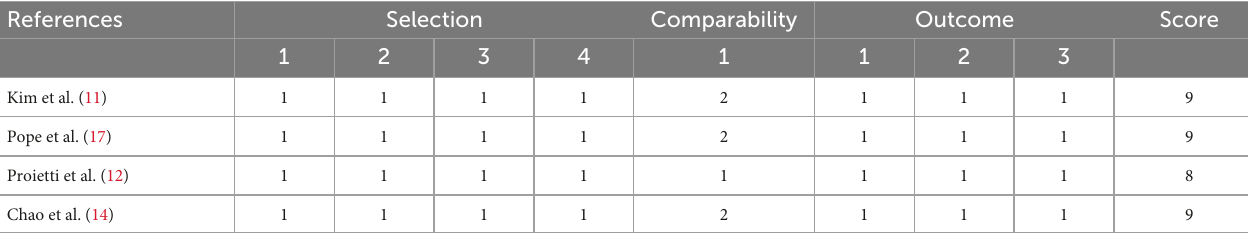
TABLE 2 (A) Quality assessment of cohort study by Newcastle-Ottawa scale.